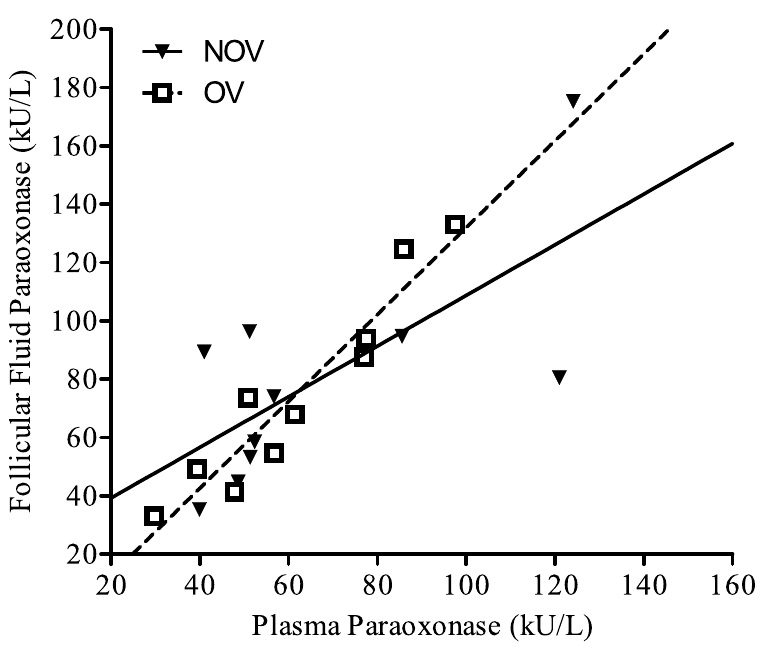
Fig 3. Scatterplot for follicular fluid and plasma paraoxonase. The associationbetweenthe follicularfluid and plasma paraoxonase concentrations was linear and significant( P < 0.001). No differences were detected betweenOV and NOV